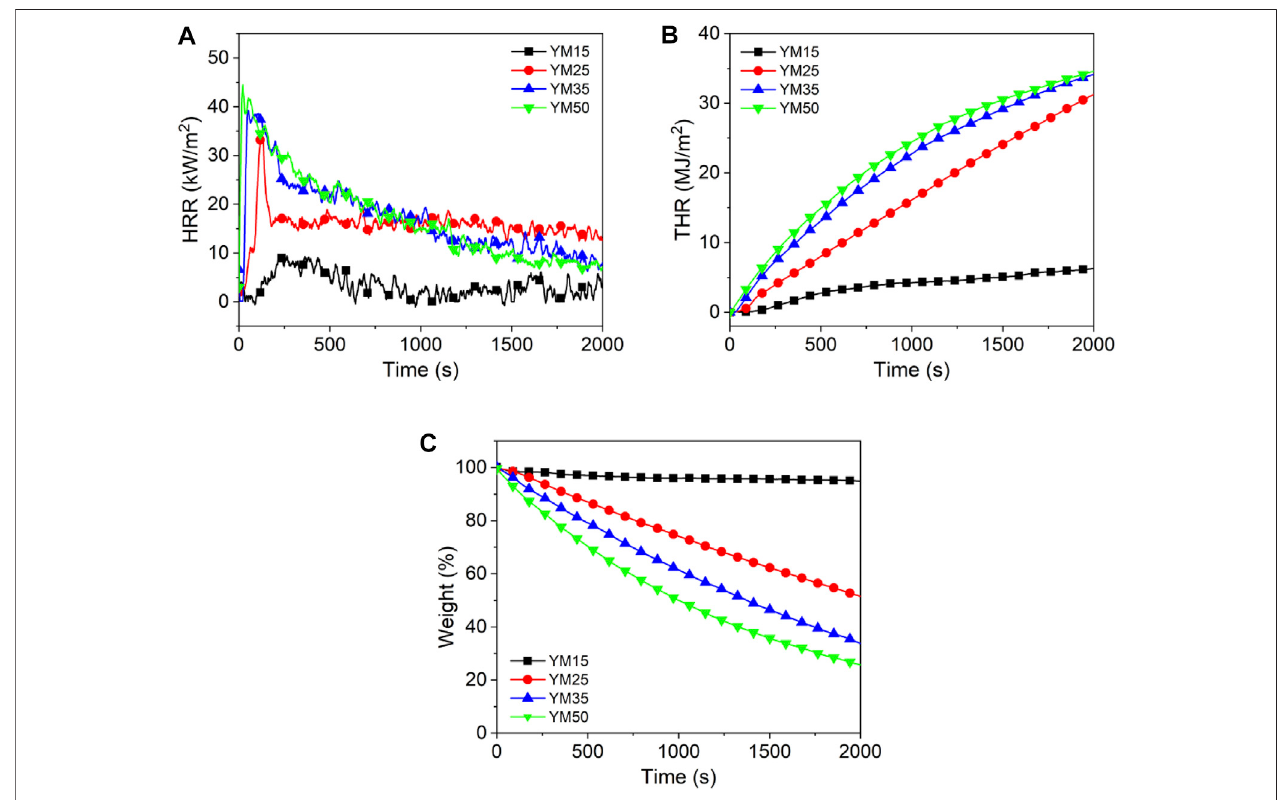
FIGURE 2 | Bitumite curves: (A) HRR, (B) THR, and (C) Char residue.